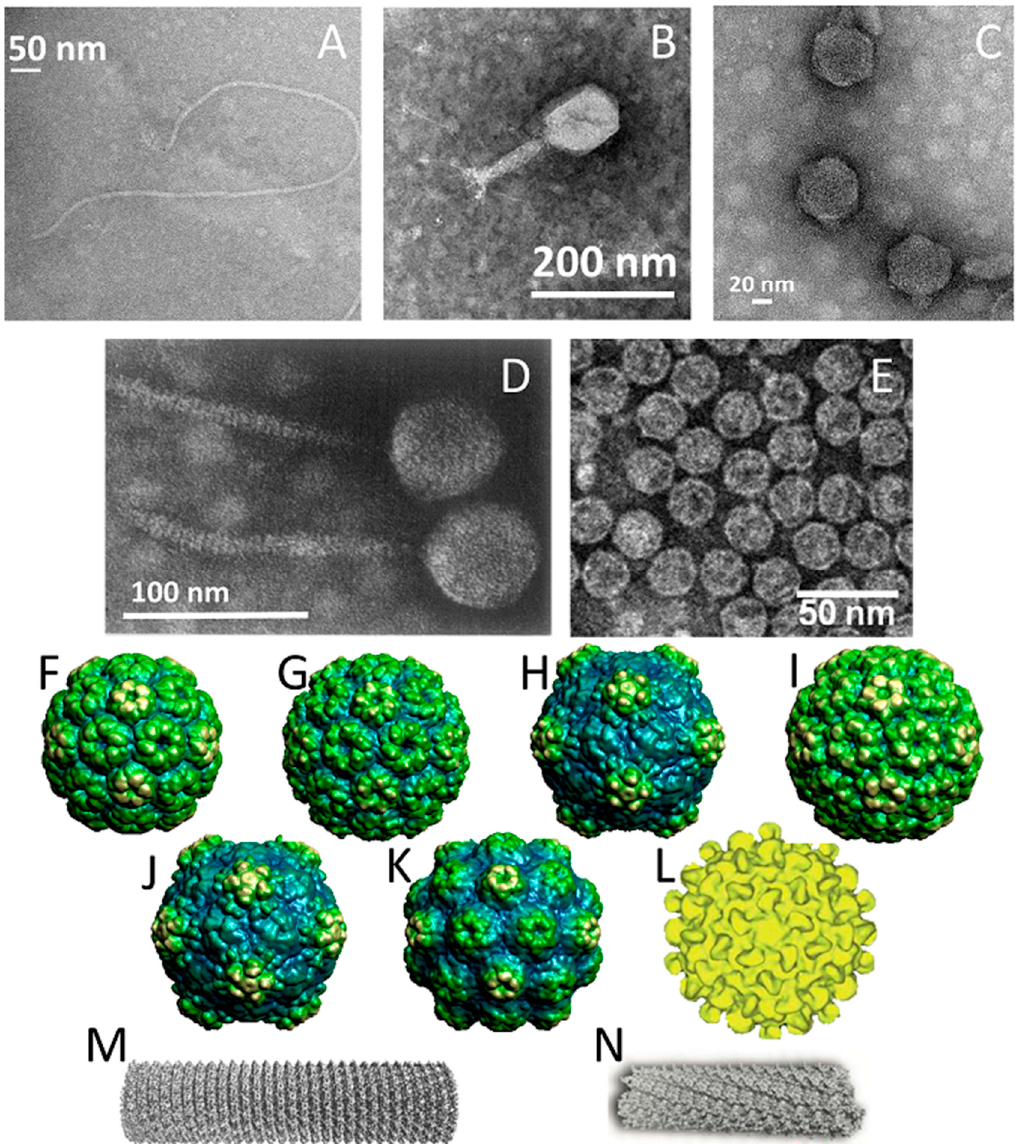
Figure 1. Structures of the viruses discussed in this review. Transmission electron microscopy